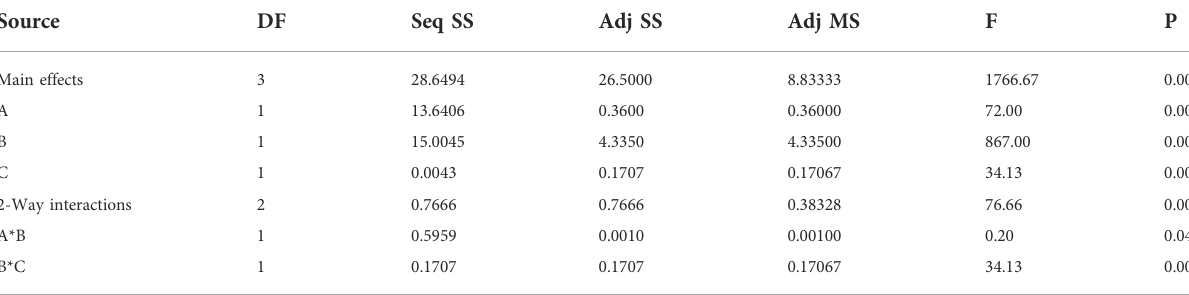
TABLE 3 Analysis of variance for H 2 S gas adsorption (coded